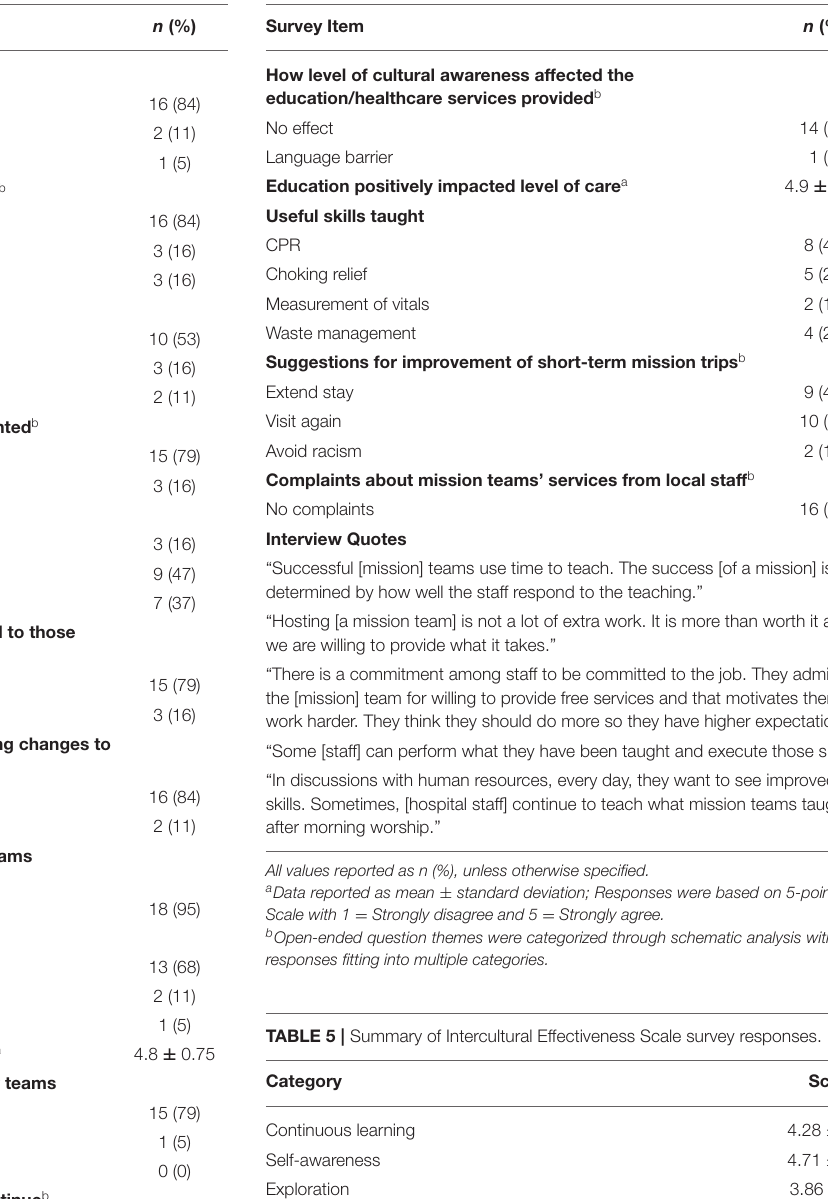
TABLE 4 | Local hospital survey and interview response summary.